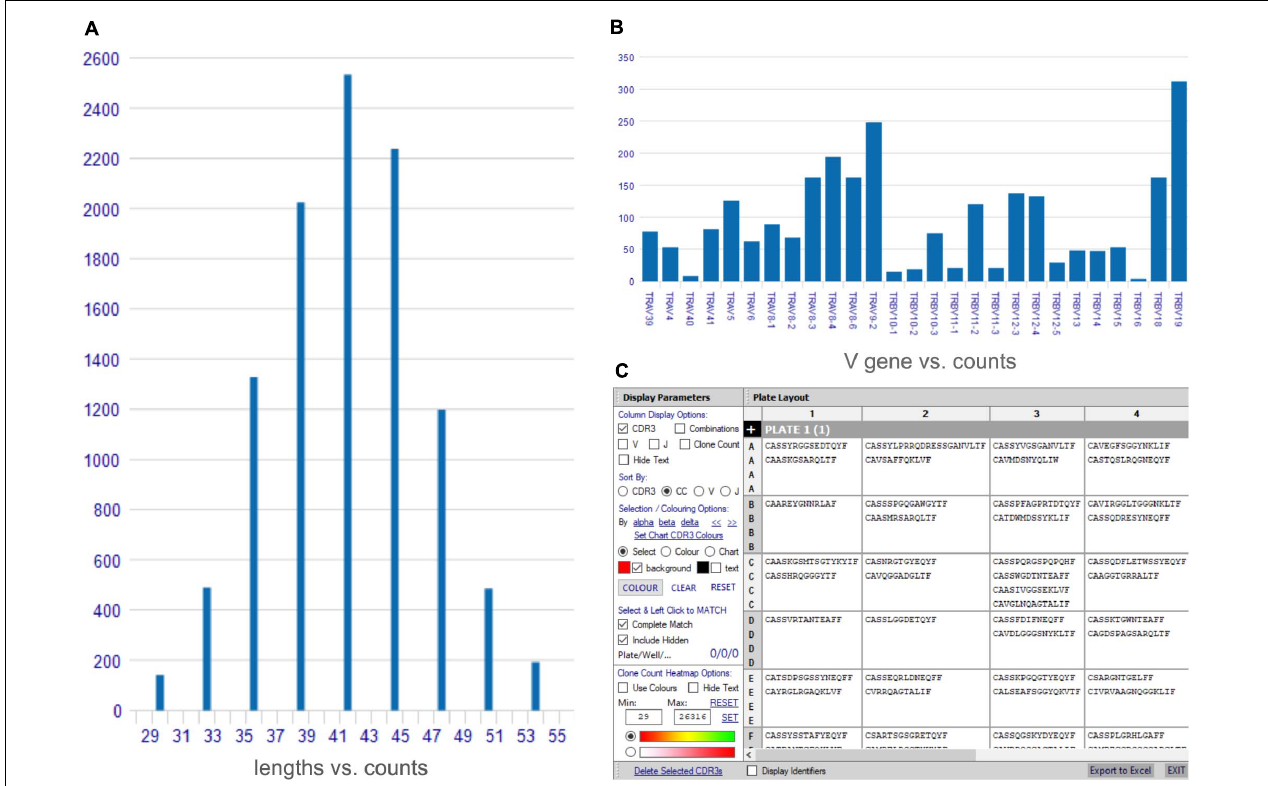
FIGURE 1 | Access tools for analysis of single-cell TCR-seq data. A variety of rapid access tools are available for analyses of single-cell TCR-seq data including (A) comparative CDR3 length histogram, (B) gene frequency histogram for individual TCR genes (TRV α and β genes shown), (C) plate/well layout explorer for plate-based assays listing paired CDR3 chain sequence, with options to show individual